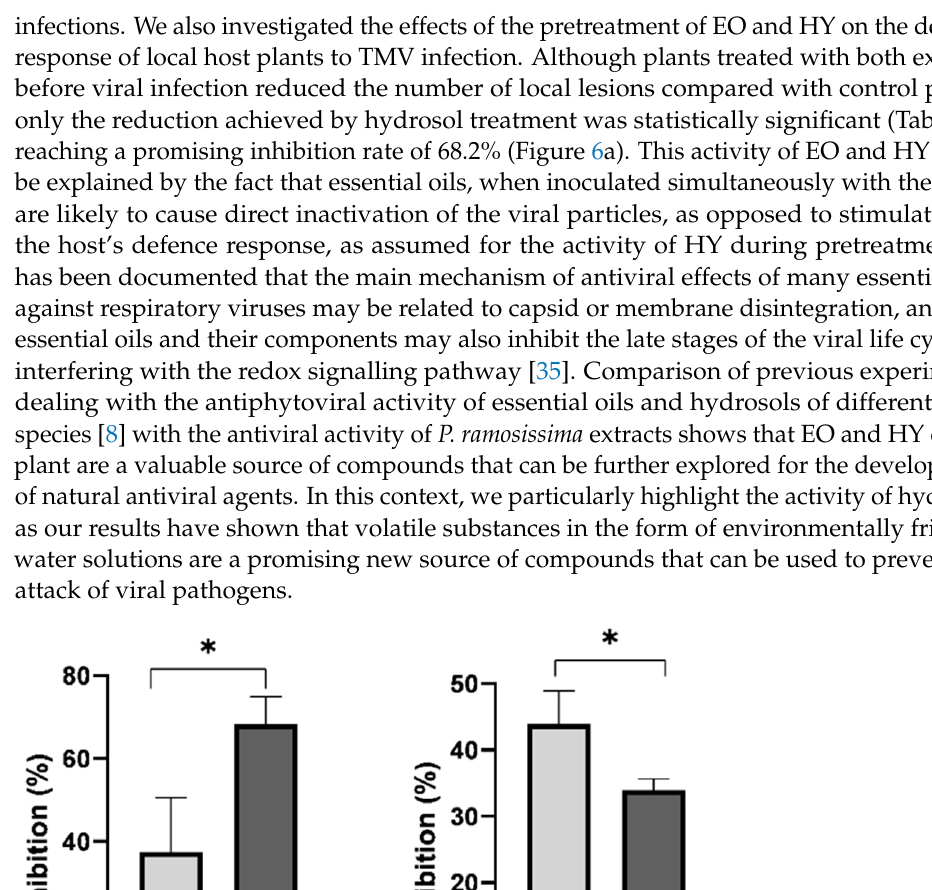
Table 4. Number of local lesions on: (a) leaves of local host plants treated with essential oil and hydrosol before virus inoculation; (b) leaf halves simultaneously inoculated with virus and essential oil or hydrosol.